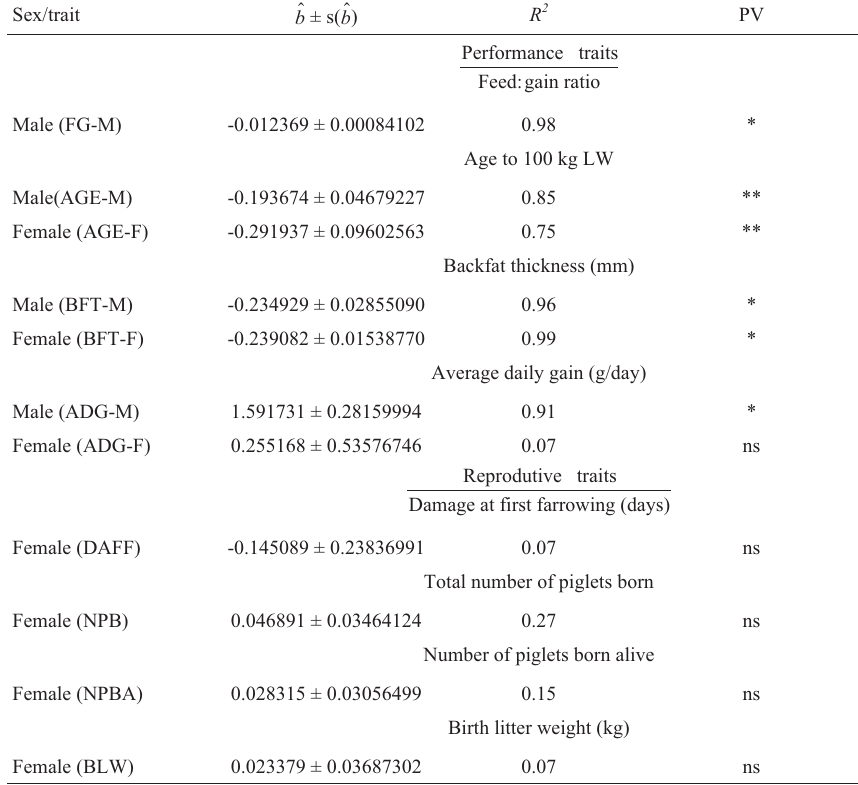
$ b )), coefficients of determination (R 2 ), and probability values (PV) for the direct